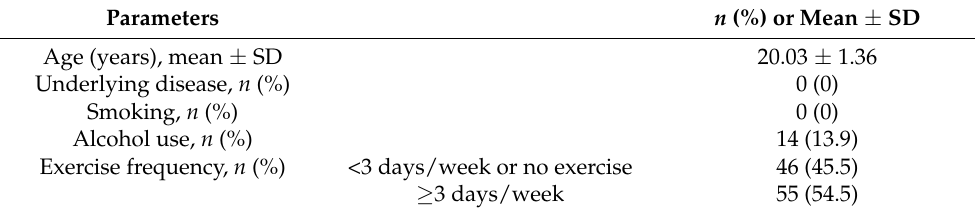
Table 1. Demographic characteristics of female college students ( n = 101).